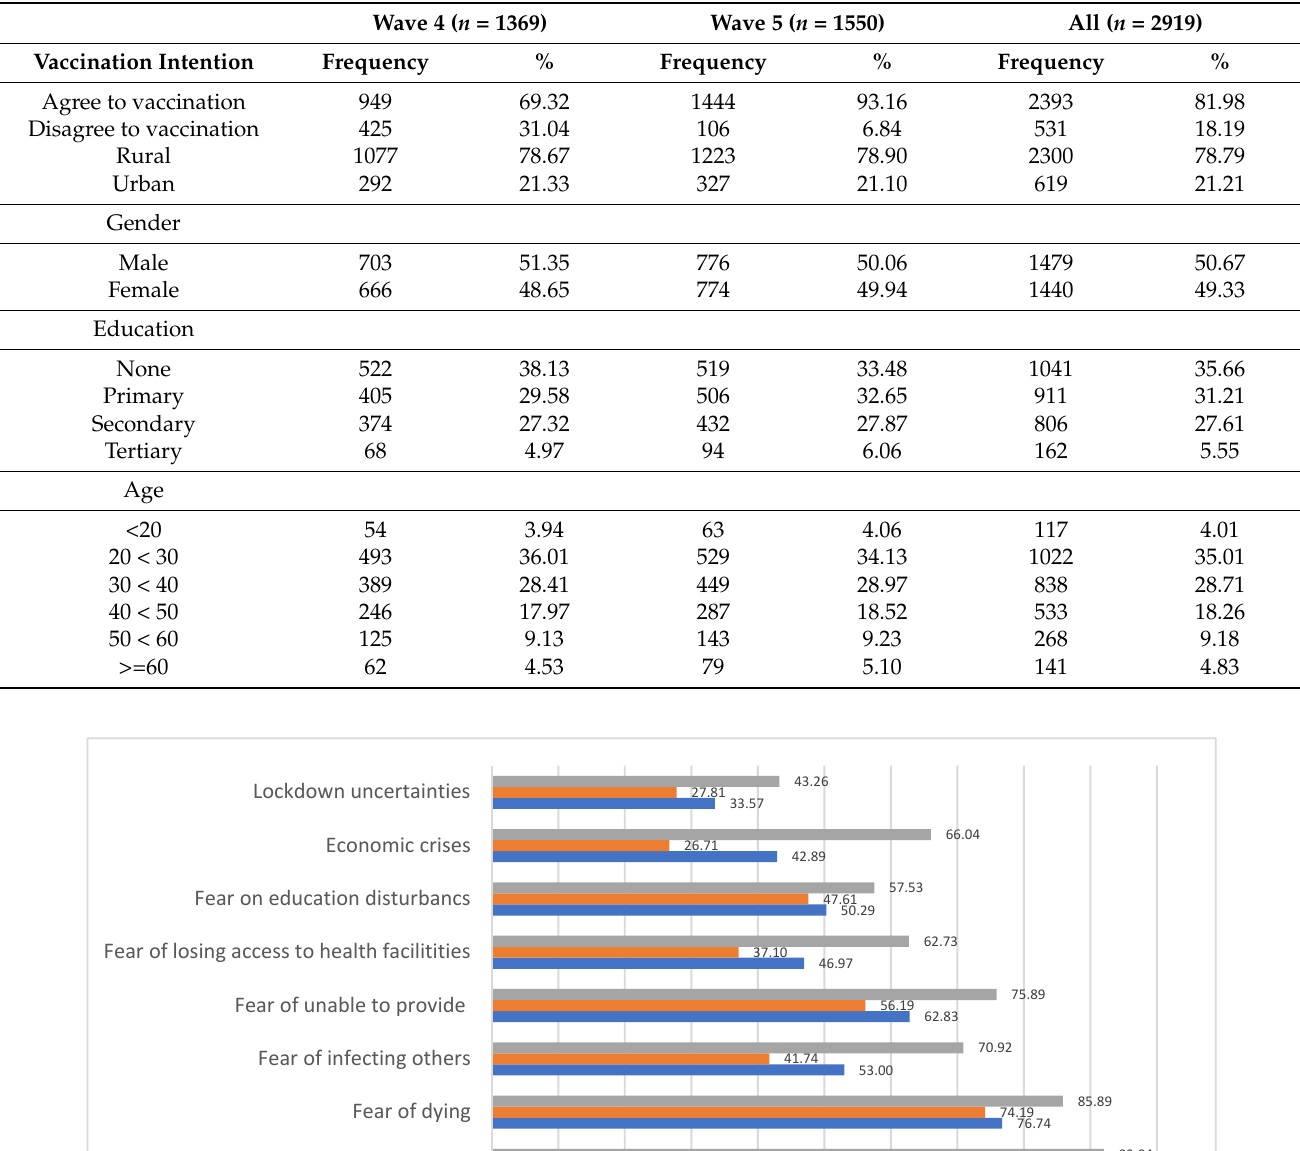
Table 3. Selected demographic characteristics and vaccination intentions.